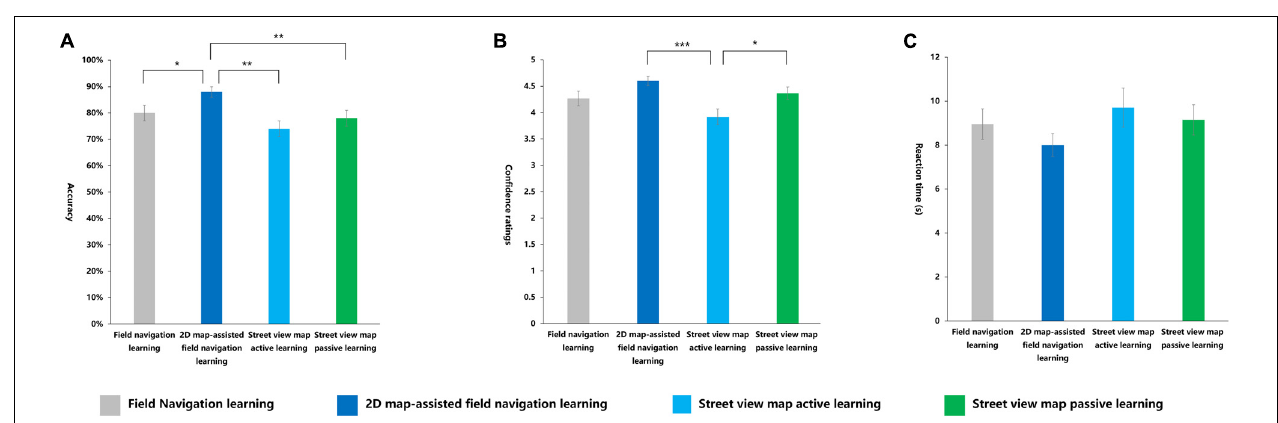
FIGURE 13 | Indexes in configurational representation task under four learning methods. (A) Accuracy, (B) confidence ratings, (C) reaction time (s). * p < 0.05; ** p < 0.01; *** p <